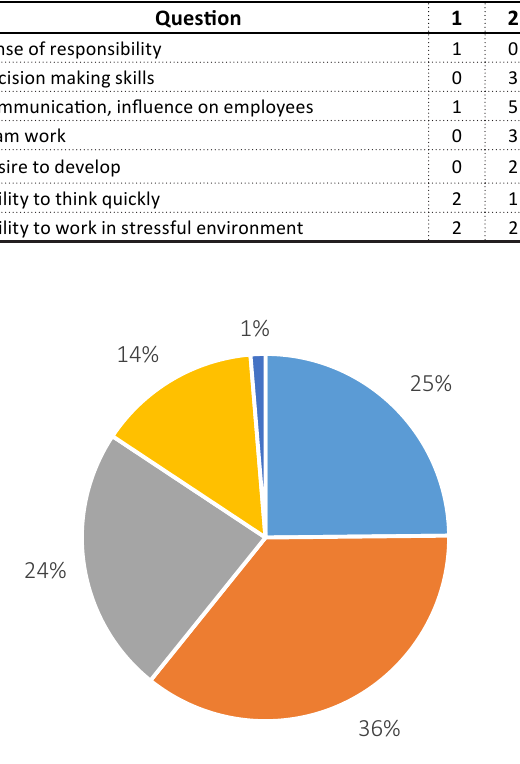
Figure 2. Women carrer growth